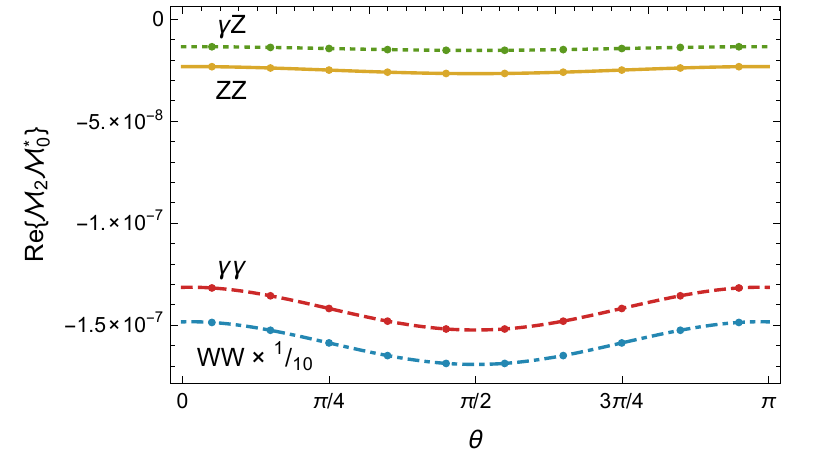
Figure 4. Dependence of various groups of two-loop box contributions on the scattering angle θ .